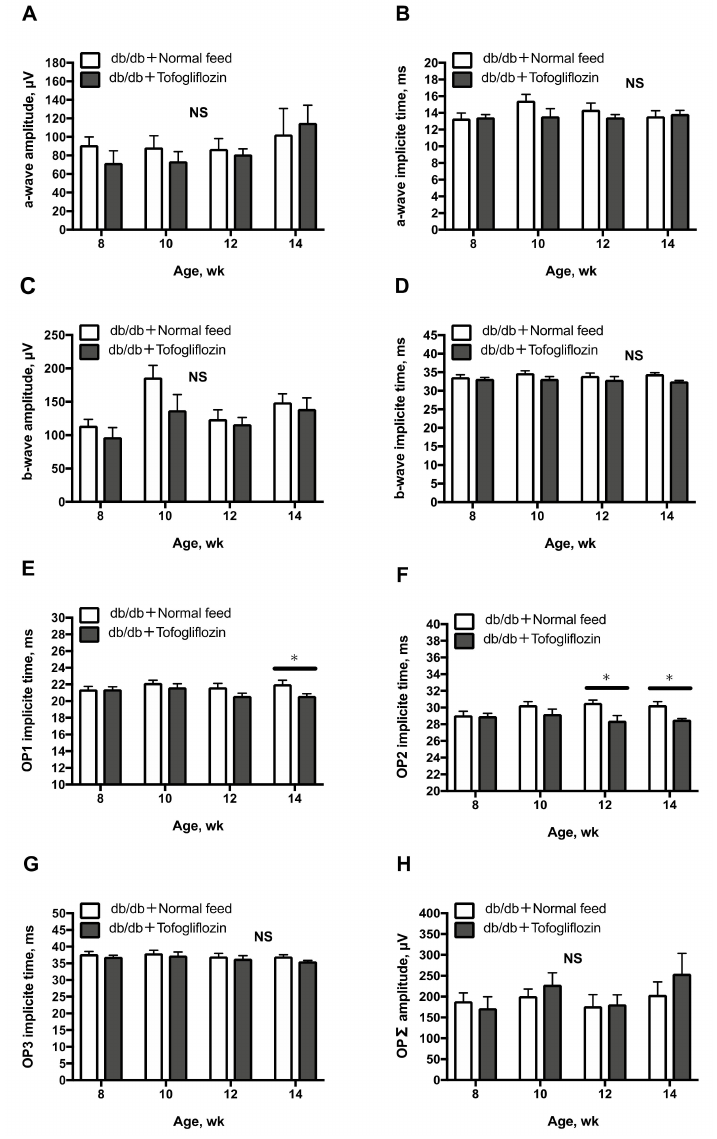
Figure 5. Longitudinal assessment of ERGs in db/db mice treated with tofogliflozin (db/db + to- fogliflozin, n = 6) and blunted in db/db mice fed normal chow (db/db + normal feed, n = 6) from 8 to 14 weeks of age: ( A ) amplitude of the a-wave; ( B ) implicit time of the a-wave; ( C ) amplitude of the b-wave; ( D ) implicit time of the b-wave; ( E ) implicit time of OP1 waves; ( F ) implicit time of OP2 waves; ( G ) implicit time of OP3 waves; ( H ) total amplitudes of OP waves ( Σ OP). There were no significant differences in the implicit time or amplitude of the a-waves ( A , B ) and b-waves ( C , D ) between the db/db + tofogliflozin mice and db/db + normal feed mice. There were no significant changes in the implicit time of the OP3 ( G ) waves or the total amplitudes of the OP waves ( Σ OP) ( H ) between the groups of mice (two-way repeated-measures ANOVA). The implicit time of OP1 ( E ) increased significantly in db/db + normal feed mice at 14 weeks of age, and the implicit time of the OP2 waves ( F ) increased significantly in db/db + normal feed mice from 12 to 14 weeks of age (two-way repeated-measures ANOVA). * p < 0.05, between